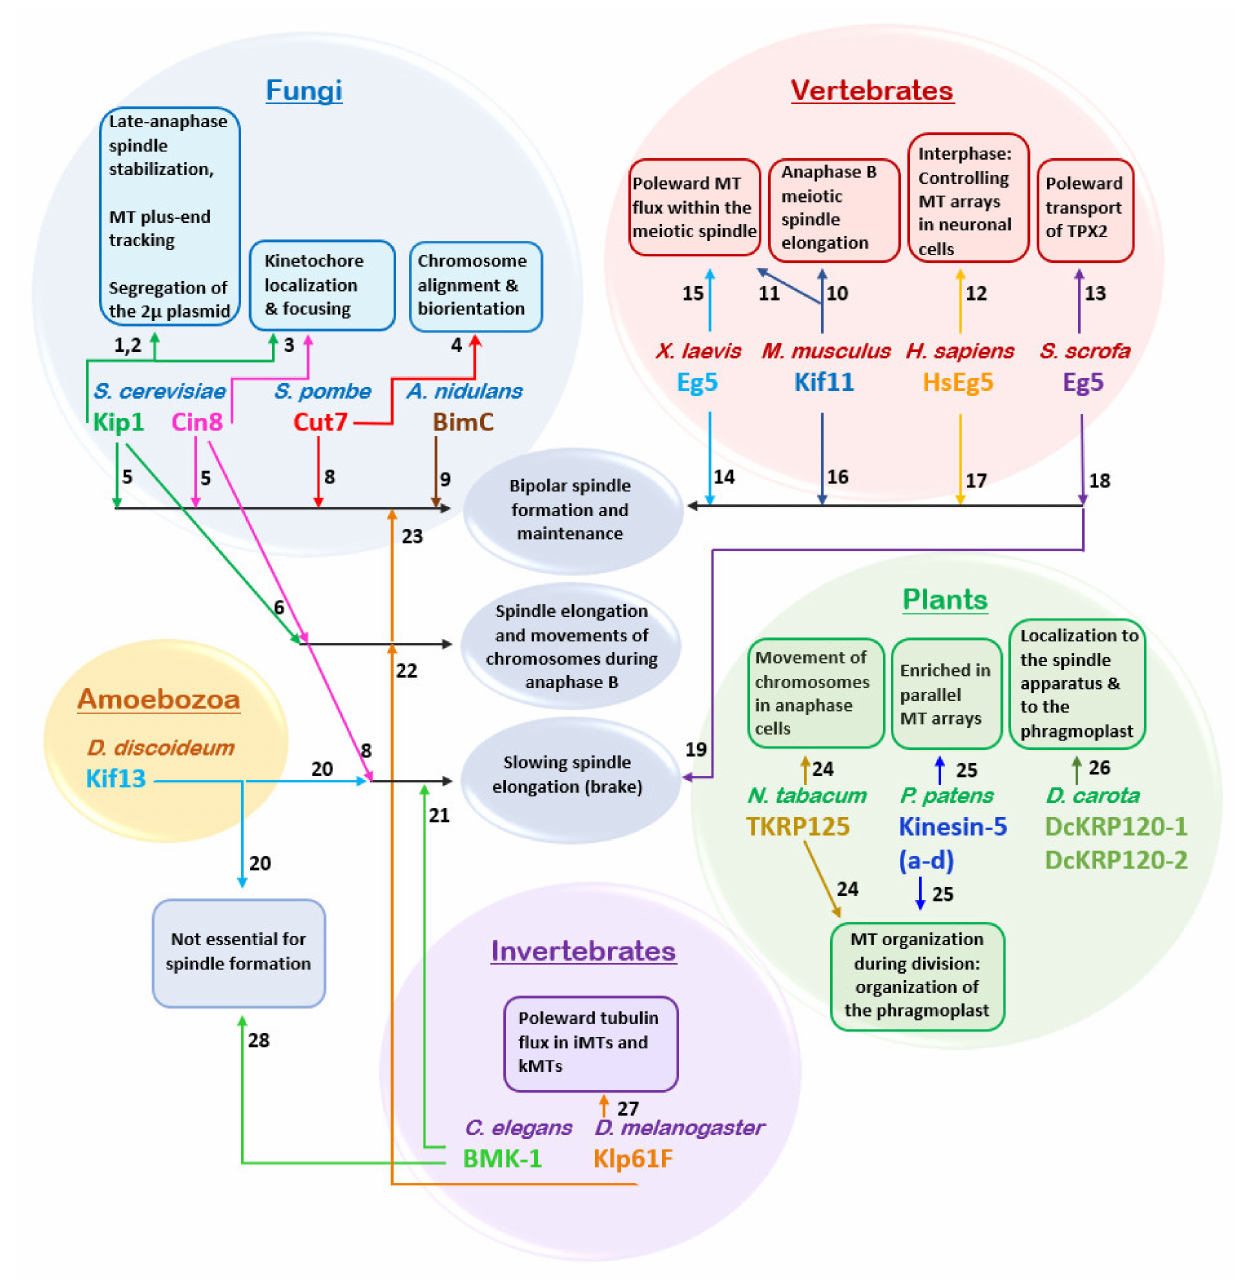
Figure 4. Physiological roles of kinesin-5 motors. Functions common to at least two kinesin-5 motors are indicated in blue ellipses. Functions identified for a single kinesin-5 motor are indicated in framed rectangles. Colored spheres indicate different groups of species. Arrows point to specific intracellular functions. Numbers indicate the related